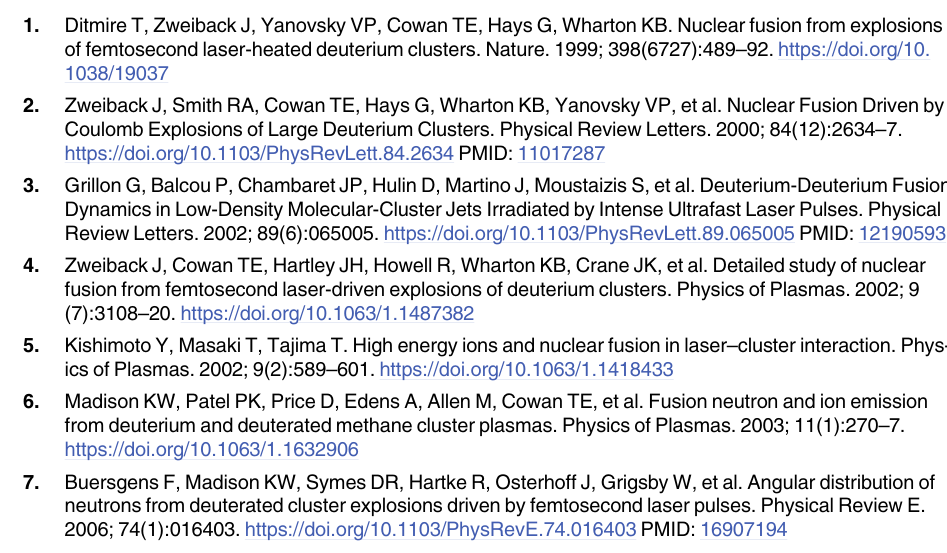
Fig 4. Ion time-of-flight signal and the expected ion temperature. (a) Ion time-of-flight signal from the MCP detector smoothed out with a Savitzky-Golay filter (SGF). The red curve shows a Maxwellian fit for deuterium ions with kT = 52 keV. (b) Expected ion temperature derived from average cluster radius with respect to the backing pressure. The blue diamond indicates the deuterium ion temperature (52 ± 2 keV) measured from the MCP time-of- flight